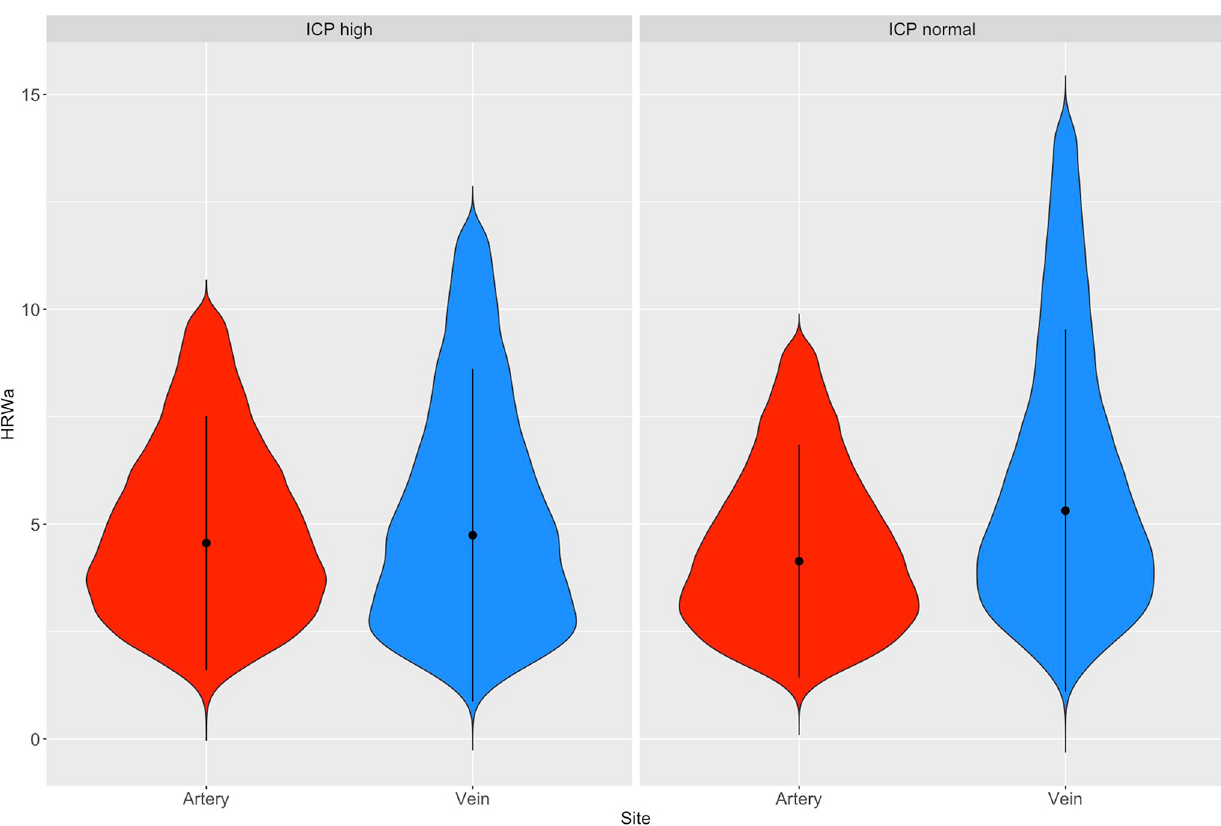
Fig 4. Violin plots of the harmonic regression waveform amplitude (HRW a ). The central marker in the violin plots indicate the median and interquartile range. Noted are the reduction of the difference in maximum and median retinal vascular pulsation amplitudes within the ICP groups as a consequence of a reduction of the venous and increase in the arterial pulsation amplitudes within the ICP h group. Between group differences indicate a ICP h and ICP n groups.